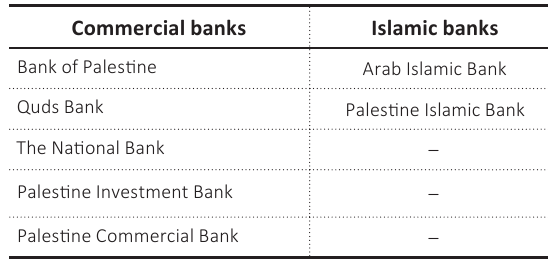
Table 1. Banks included in the study